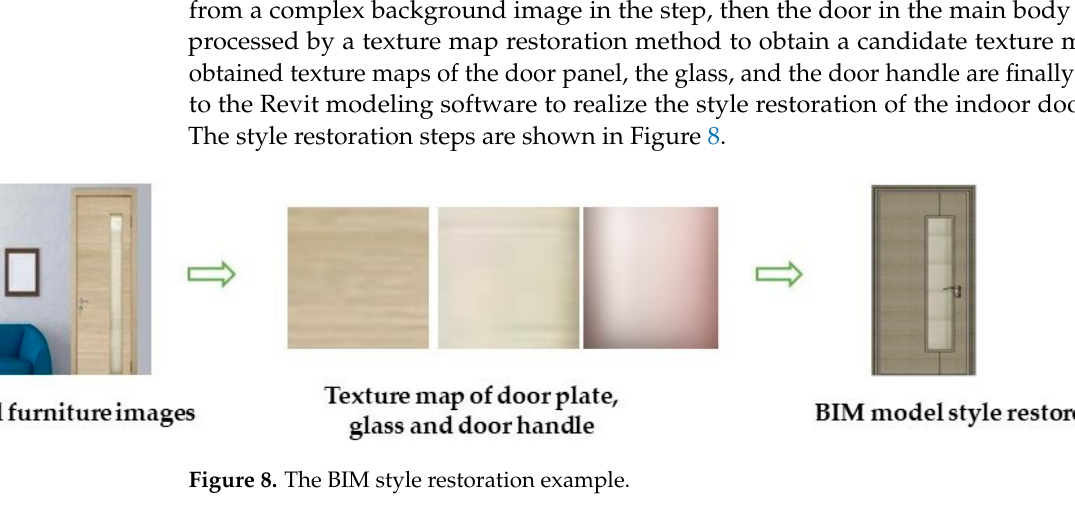
Figure 7. Example of the retrieval result of the BIM door model outline drawing.